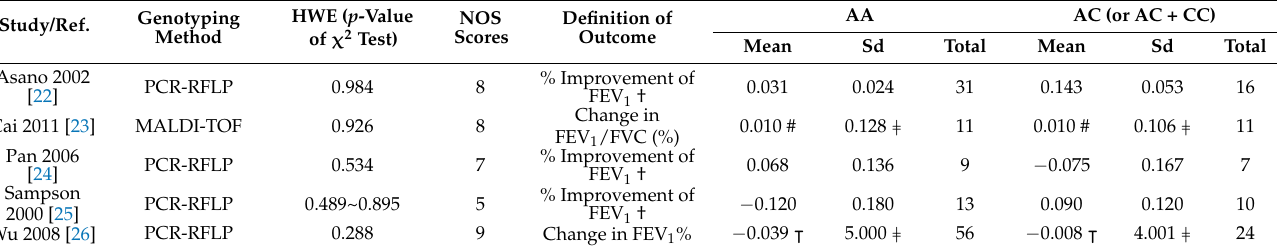
Table 4. Genotype characteristics of studies included in LT4CS-444A/C gene meta-analysis.